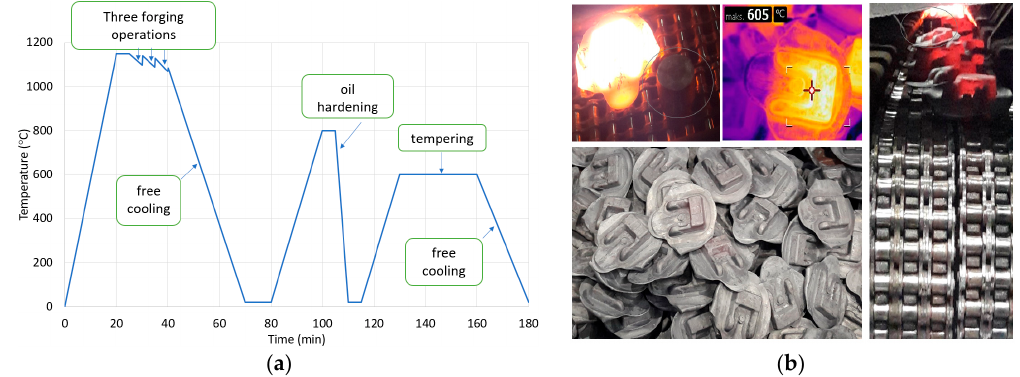
Figure 3. The views of ( a ) typical die-forging process an example with a separate heat treatment, ( b ) photos of forked forgings during and after a controlled cooling process.